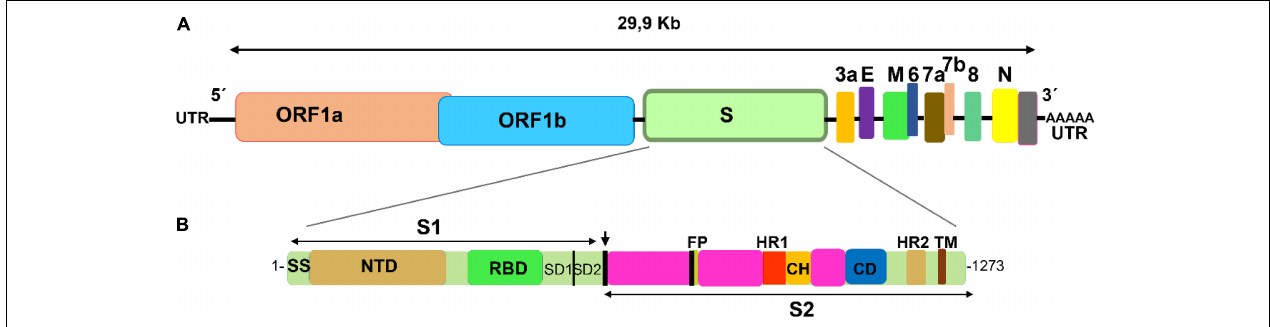
FIGURE 1 | Schematic representation of SARS-CoV-2 genome and spike functional domains. (A) SARS-CoV-2 single stranded positive RNA contains two large ORF genes that encode 16 non-structural proteins, and four genes that encode four essential structural proteins: the spike (S), the envelope (E), the membrane (M), and the nucleocapsid (N). In addition, the genome contains a number of accessory genes (3a, 6, 7a, 7b, and 8). (B) The spike gene encodes two spike subunits, S1 and S2. The cleavage site between S1 and S2 is indicated with an arrow. The S1 subunit contains a domain (RBD, receptor binding domain) close to the C-terminus, which recognizes and binds the angiotensin-II conferring enzyme receptor (ACE-2). Fusion and entry of the virus into the receptor cell is mediated by the S2 subunit, which contains a fusion protein (FP) and two heptad repeat motifs (HR1 and HR2). For comparison, image follows the schematic representation for SARS-CoV in Song et al. (2019).